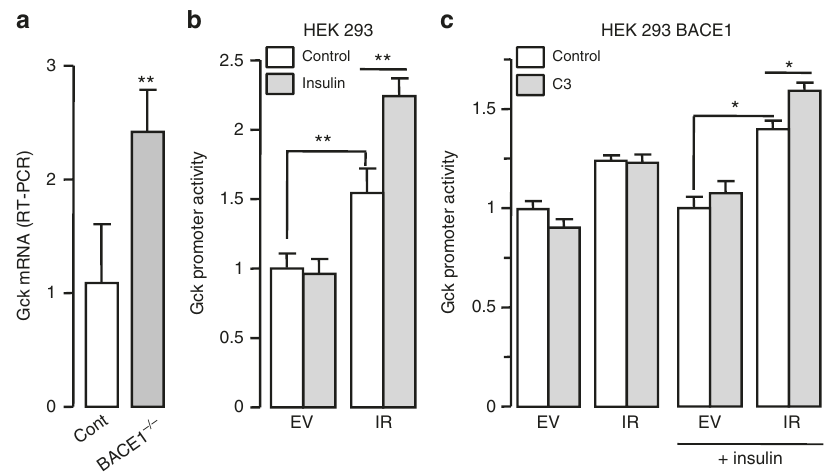
Fig. 7 Regulation of glucokinase expression by IR amount. a Levels of GCK mRNA were measured by RT-PCR in control and BACE1 − / − primary hepatocytes. Native HEK 293 cells ( b ) or HEK 293 cells overexpressing BACE1 ( c ) were transfected with empty vector (EV) or with IR coding vector together with human GCK promoter-driven Fire fl y luciferase and SV40-driven Renilla luciferase coding vectors where indicated, serum-deprived cells were treated with the BACE1 inhibitor (C3; 20 μ M) and then stimulated with insulin (2 nM, 7 h). Fire fl y and Renilla luciferase were measured in cell lysates, and GCK promoter activity was calculated as the ratio of Fire fl y/Renilla luciferase and expressed as fold over the situation without IR overexpression nor insulin stimulation. Data are means ± s.d. Statistical analyses were made using unpaired t -test ( a ) or ANOVA, followed by Bonferonni ’ s test ( b , c ). * p < 0.05; ** p < 0.01